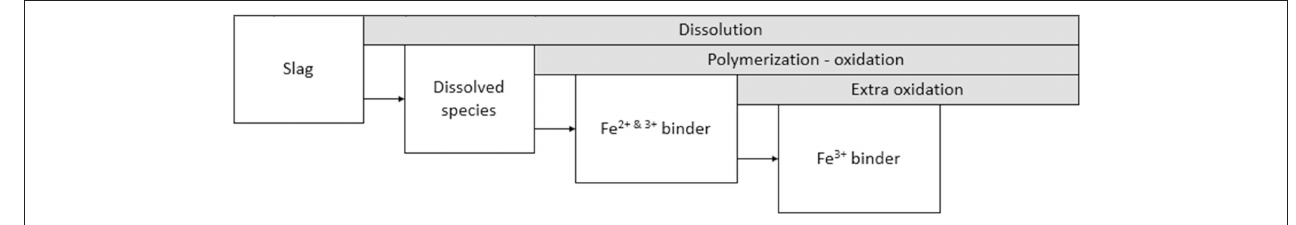
FIGURE 8 | Schematic of the sequence of reaction